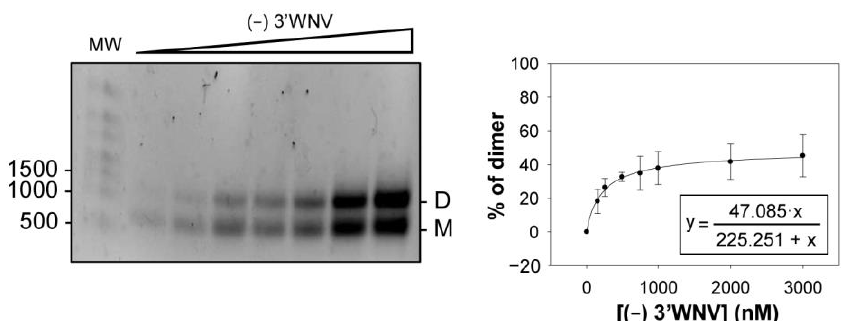
Figure 6. The ( − ) RNA of the WNV 3 ′ UTR dimerizes in vitro. The antisense sequence of 3 ′ WNV RNA (( − ) 3 ′ WNV) was synthesized and analyzed to evaluate its dimerization ability. Different concentrations of the ( − ) 3 ′ WNV were incubated under dimerization reaction conditions, and dimers were resolved as described above (left panel). The percentage of dimers was quantified, and data were fitted to a non-linear equation to calculate the final reaction yield and the K d values (right panel). Data are the mean of three independent assays ± standard deviation.